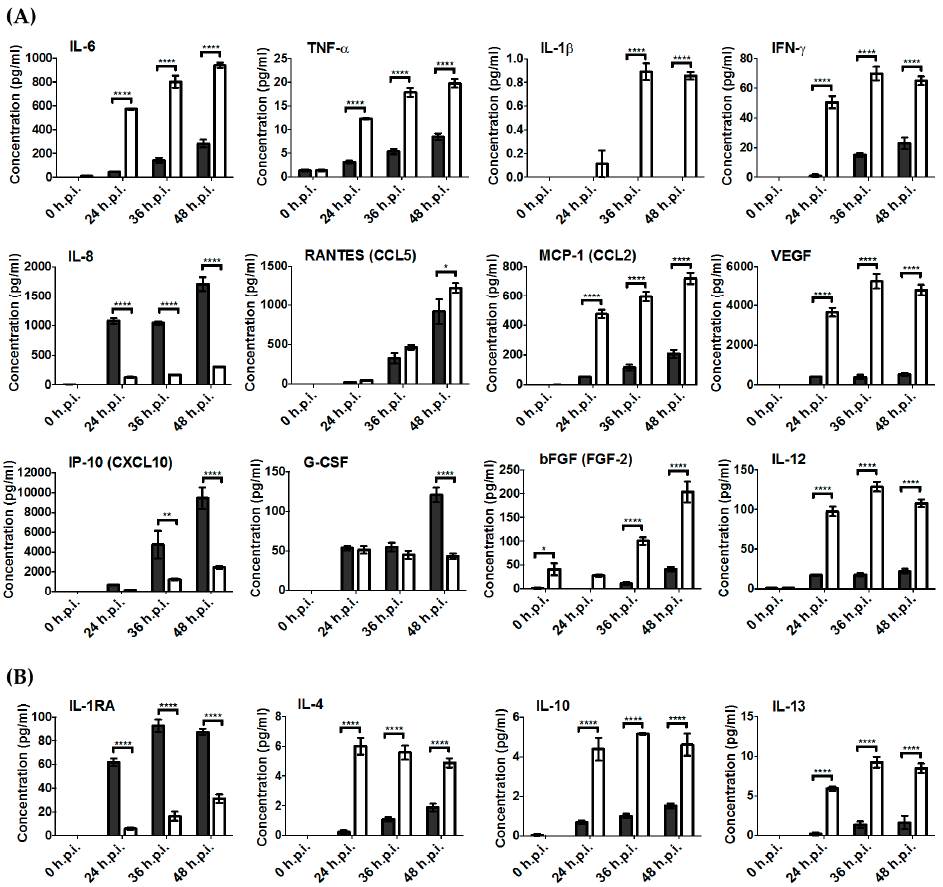
Figure 4. Soluble mediators present during Ross River virus (RRV) infection in human chondrocytes cells (grey) and skeletal muscle cells (white) primary cells at 0, 24, 36, and 48 h post-infection (h.p.i.). ( A ) Pro-inflammatory and ( B ) anti-inflammatory cytokine levels were measured using the Biorad Bio-Plex ® multiplex system. Statistical analysis was performed by two-way ANOVA statistical analysis with Bonferroni’s test. * p < 0.05; ** p < 0.01, **** p < 0.0001.